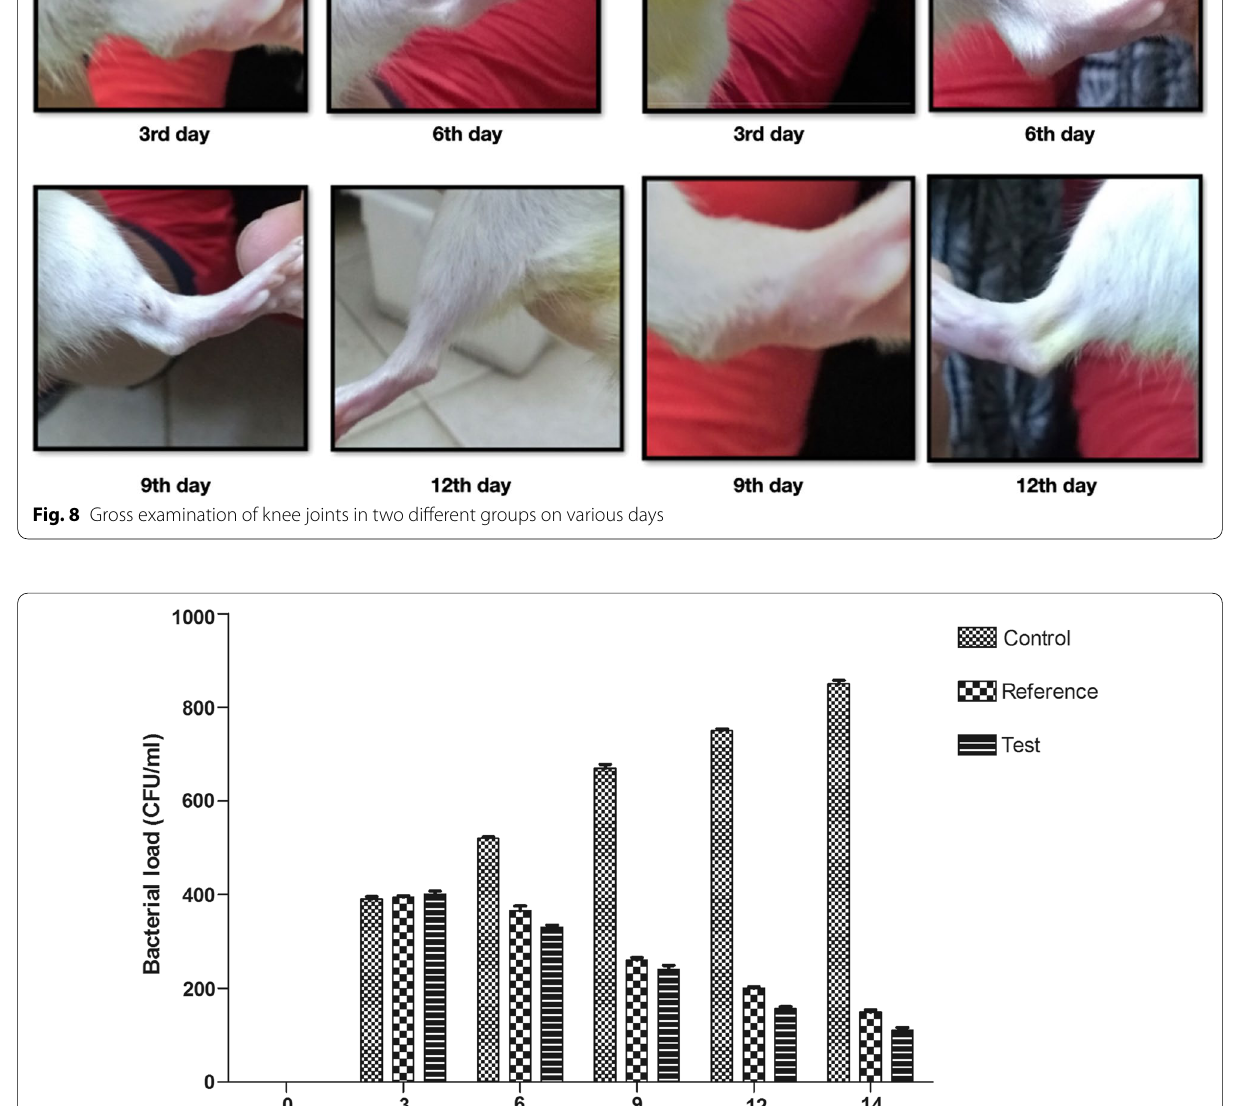
a significant effect on Y 2 and Y 3 , which were also con- firmed from respective 3D response surface plots and contour plots (Figs. 1, 2, 3) Then, the formula for opti- mized formulation (Table 4) was collected by desirabil- ity and overlay plots. BBD used for generating a surface